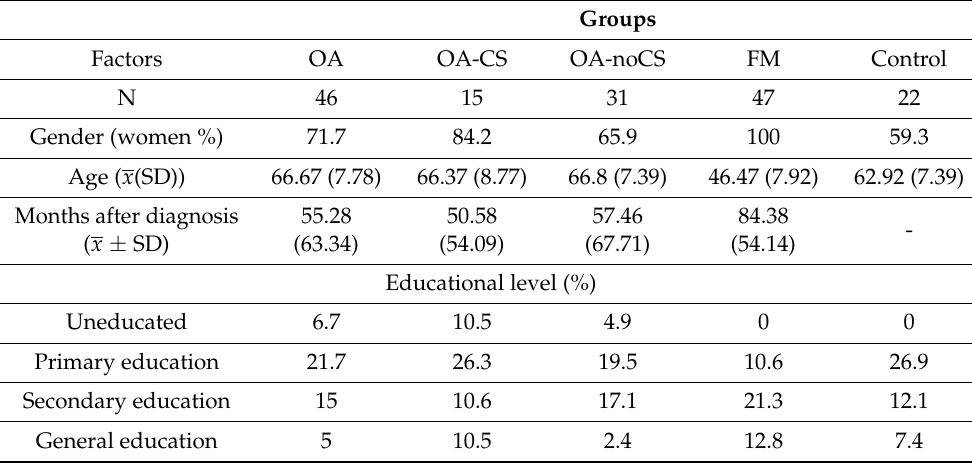
Table 1. Sociodemographic and clinical characteristics of the